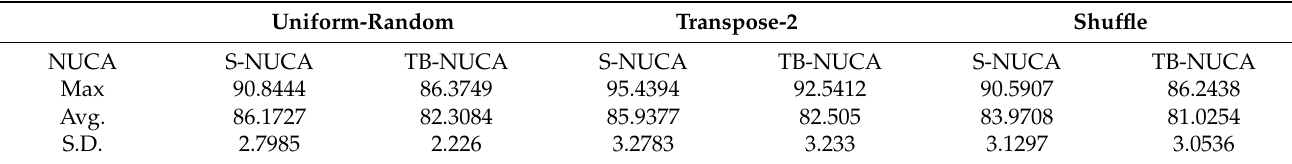
Figure 5. Temperature distribution comparison under different traffic conditions. ( a ) Random. ( b ) Transpose-2. ( c ) Shuffle. Table 2. Comparison of temperature distribution between TB-NUCA and